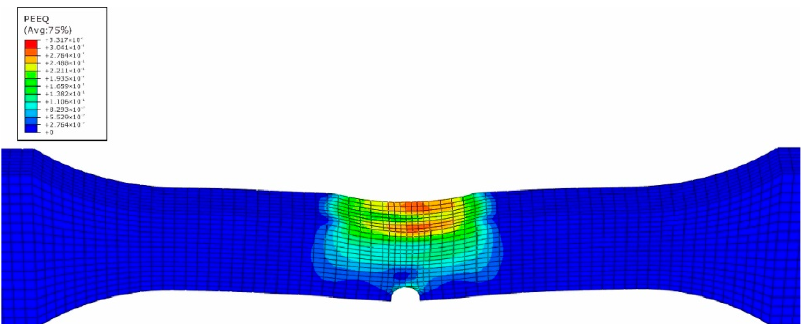
Figure 9. Strain field of impacted surface of dissimilar lightweight materials welded joint.